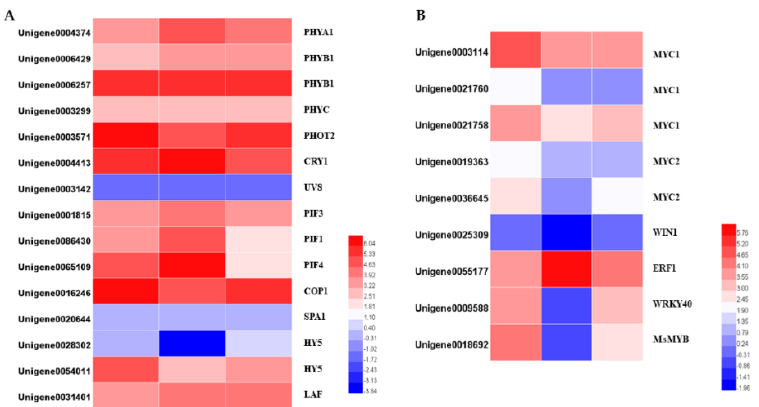
Figure 9. Heatmaps of the DEGs in the light signal transduction pathway ( A ) and heatmaps of differentially expressed transcription factors ( B ).